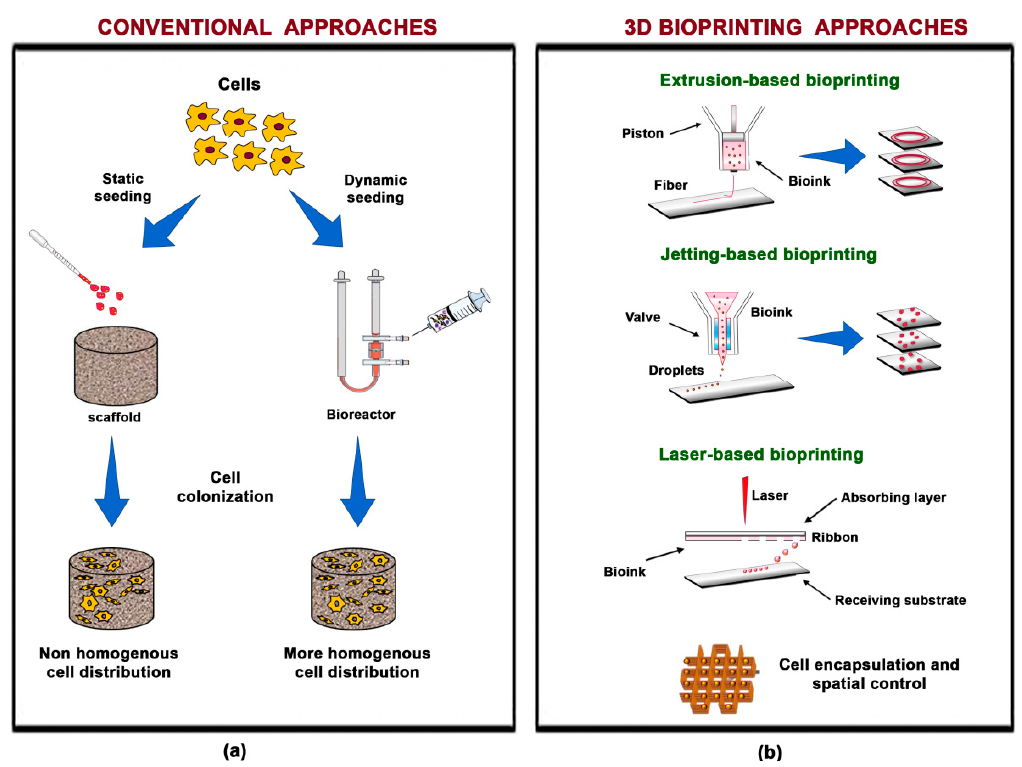
Figure 1. Comparison between tissue engineering conventional and three-dimensional (3D) bioprinting approaches. ( a ) In the conventional method, cells can be seeded in vitro in a static and/or dynamic mode onto a previously fabricated scaffold. The static seeding allows a non-homogenous cell distribution into the scaffold. The dynamic seeding can be carried out with different types of bioreactors to favor a more homogenous cell distribution. Here, there is an example of a perfusion bioreactor performing 3D cell seeding. Both types of “conventional” tissue-like constructs need to be subsequently shaped by the surgeon to match the defect site; ( b ) Representation of the main three bioprinting techniques: extrusion-based bioprinting; jetting-based bioprinting, and laser-based bioprinting. Such options allow cell encapsulation, spatial control, and the match between implant and defect size in the clinical